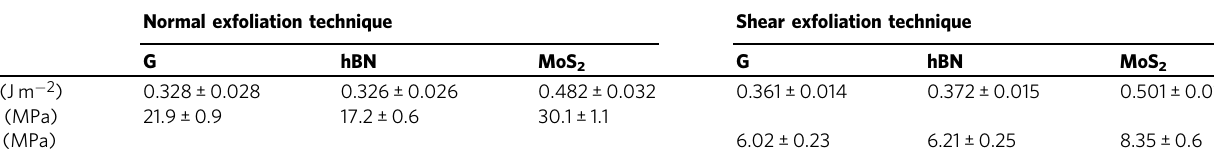
Table 1 Cohesion energy ( Γ ), intrinsic cleavage strength ( σ s ) and intrinsic interlayer shear strength ( τ s ) of 2D crystals. Normal exfoliation